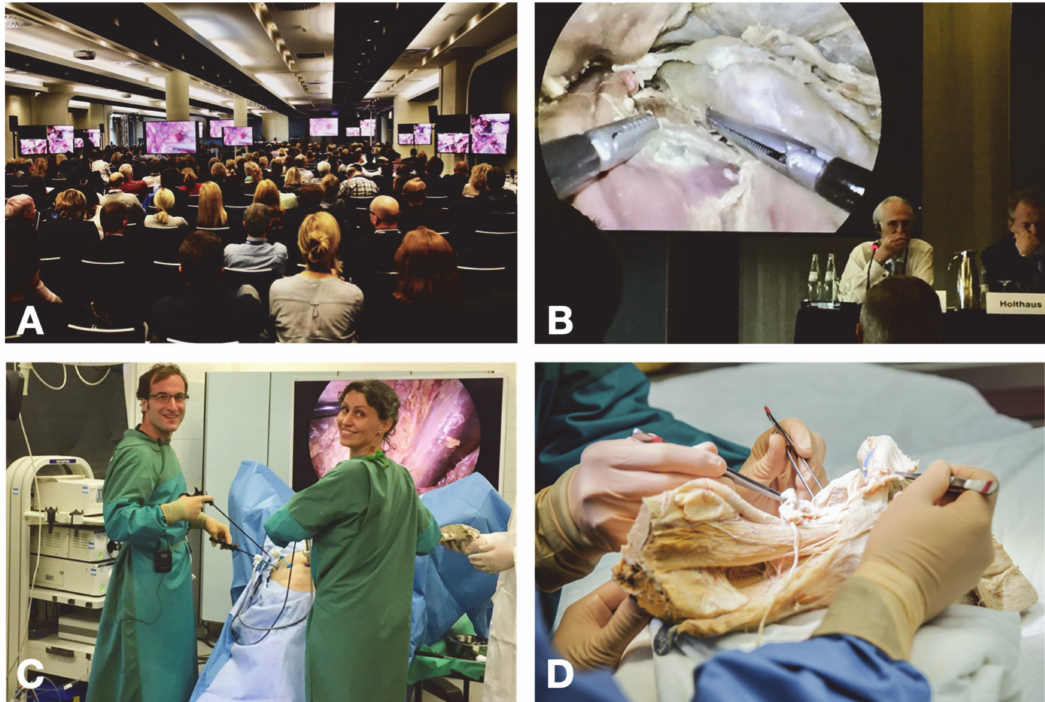
Figure 1. Set-up of the live surgery event. ( A ): Conference room equipped with several HD monitors for transmission of the live surgery event. ( B ): Transmission of laparoscopic procedures performed on a body donor from the attendees’ perspective. ( C ): Technical setting for live surgery performed on a body donor. ( D ): Demonstration of relevant anatomical structures on a formalin-fixed pre-dissected anatomical specimen